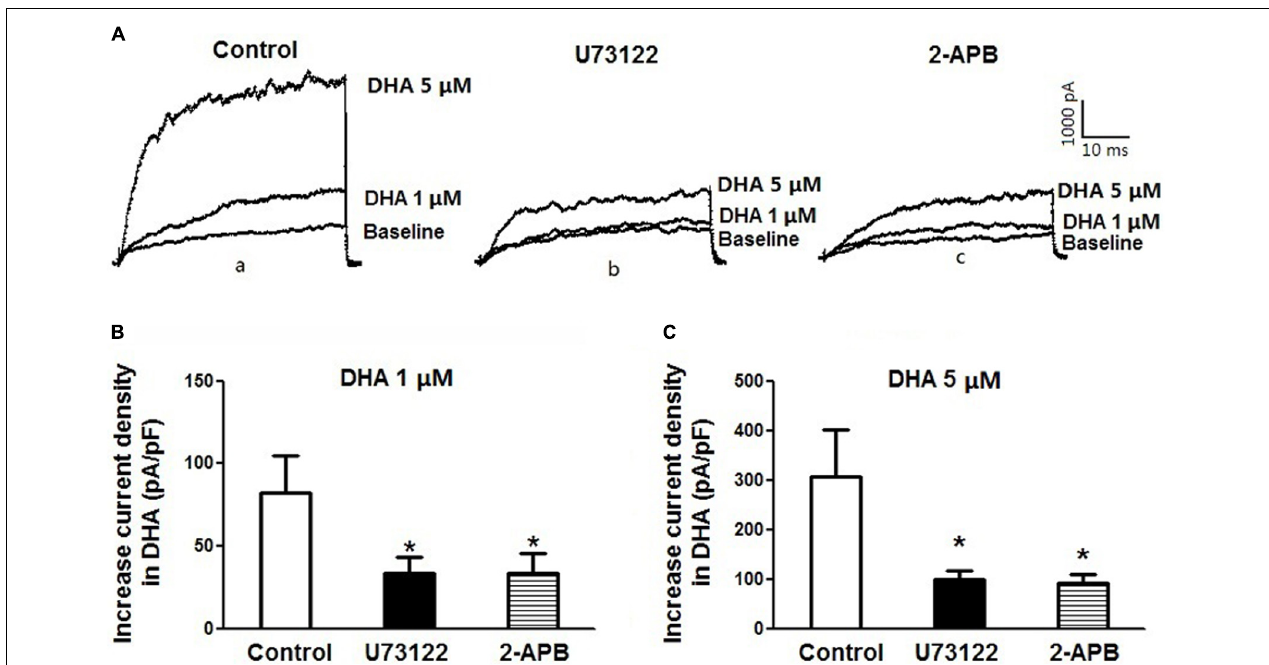
FIGURE 6 | Inhibition of PLC–IP 3 signal pathway reduces DHA-induced BK activation. (A) Representative current traces showing BK currents at baseline and after exposure to 1 and 5 µ M of DHA of rat CASMCs in cells without treatment (control) (a) and those after incubation with U-73122 (b) or 2-APB (c) . (B) Group data in bar graphs showing increased current densities after exposure to 1 µ M DHA in rat CASMCs with or without pre-incubation with U-73122 or 2-APB in bar graphs, n = 5 cells, ∗ P < 0.05 c vs. control group. (C) Group data of increased current densities after exposure to 5 µ M DHA of rat CASMCs with or without pre-incubation, n = 5 cells, ∗ P < 0.05 vs. control.